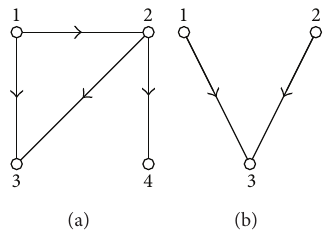
Figure 1: Directed graphs corresponding to Examples 8 and 9.